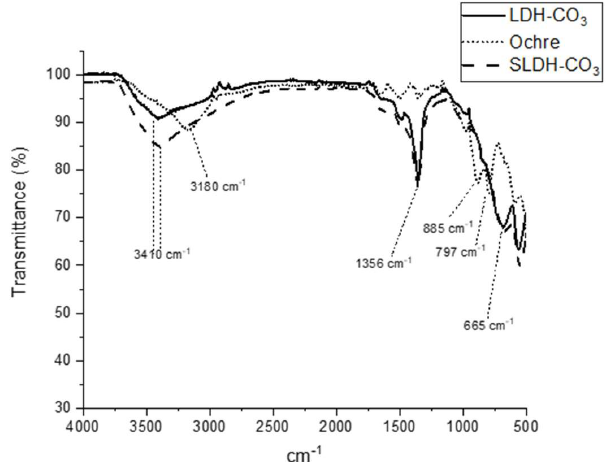
Figure 3. Fourier transform infrared spectra of both layered double hydroxide (LDH) samples (LDH-CO 3 = ochre derived LDH; SLDH-CO 3 = metal salt derived LDH) and Saltburn ochre. O–H stretching from 3000 to 3500 cm − 1 . Stretching of the C = O bonds at 1356 cm − 1.